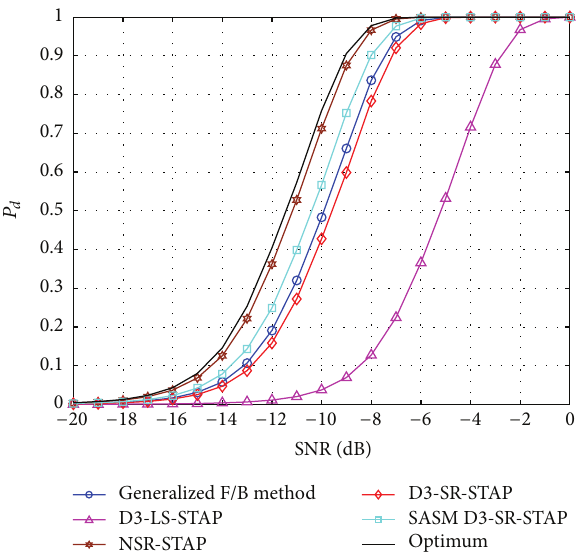
Figure 10: 𝑃 𝑑 versus the target SNR considering channel